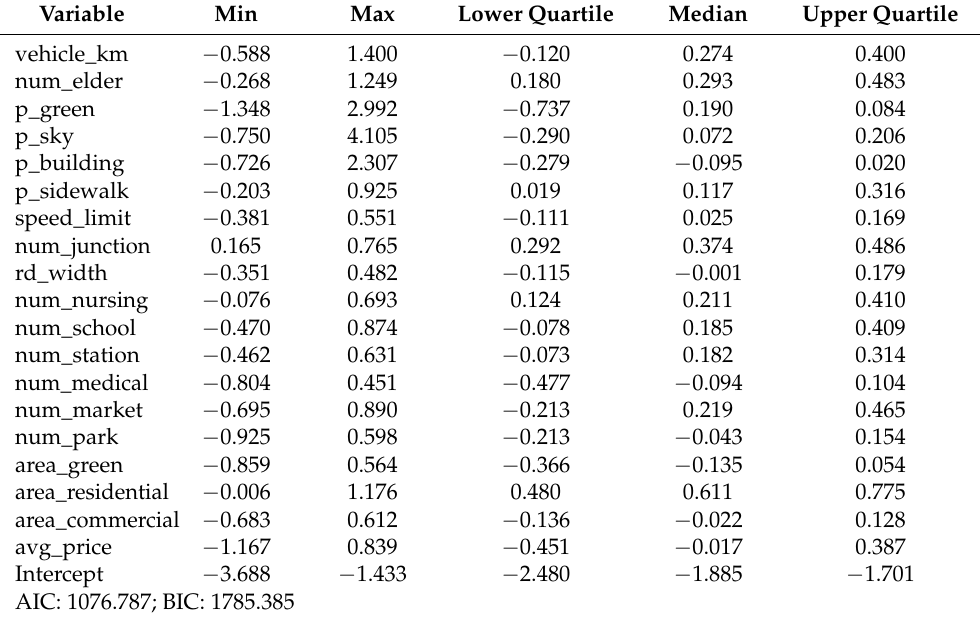
Table 4. Descriptive statistics of coefficients of